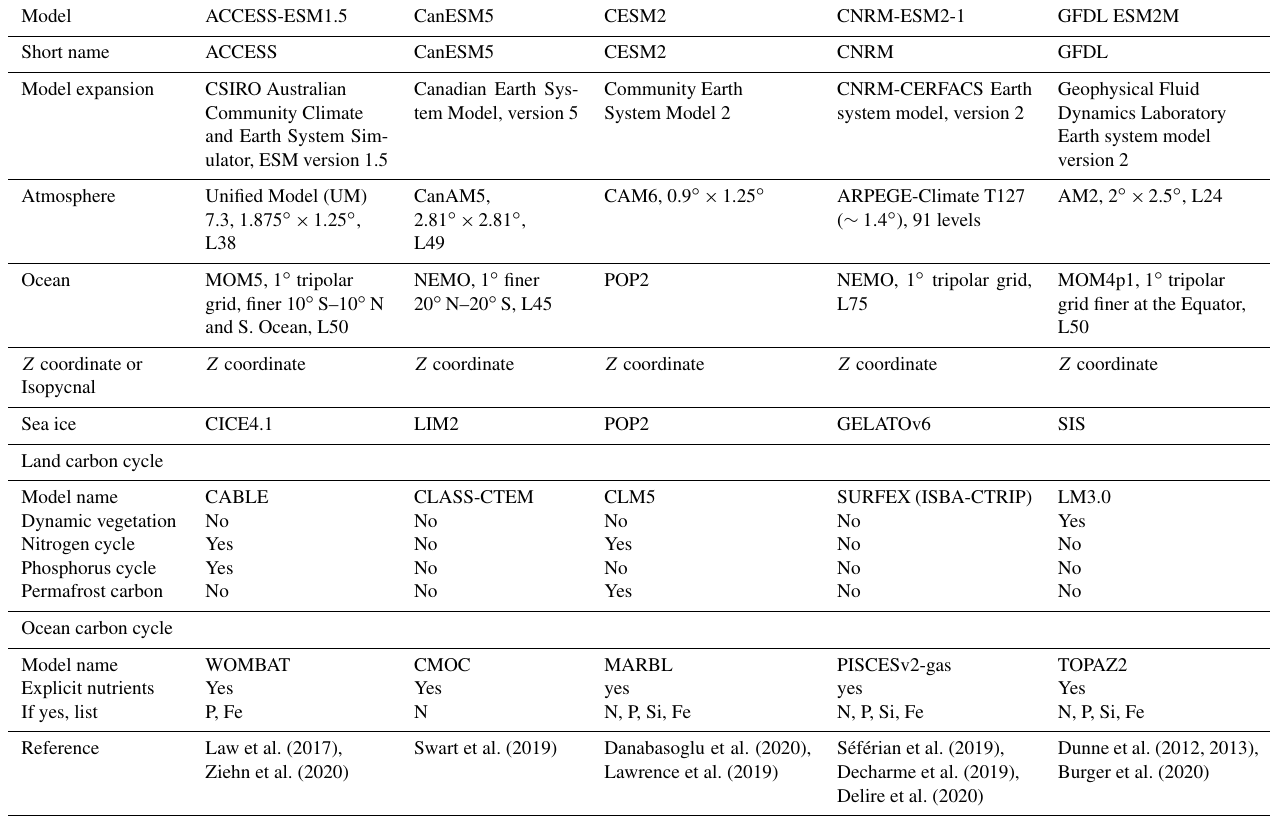
Table A1. Model descriptions of the atmospheric, oceanic, and carbon cycle components for the full Earth System Models (ESMs) that participated in this